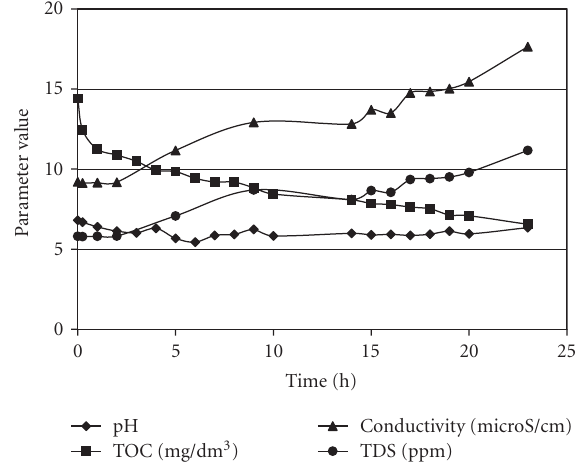
Figure 4: The changes of parameters monitored during the photocatalytic